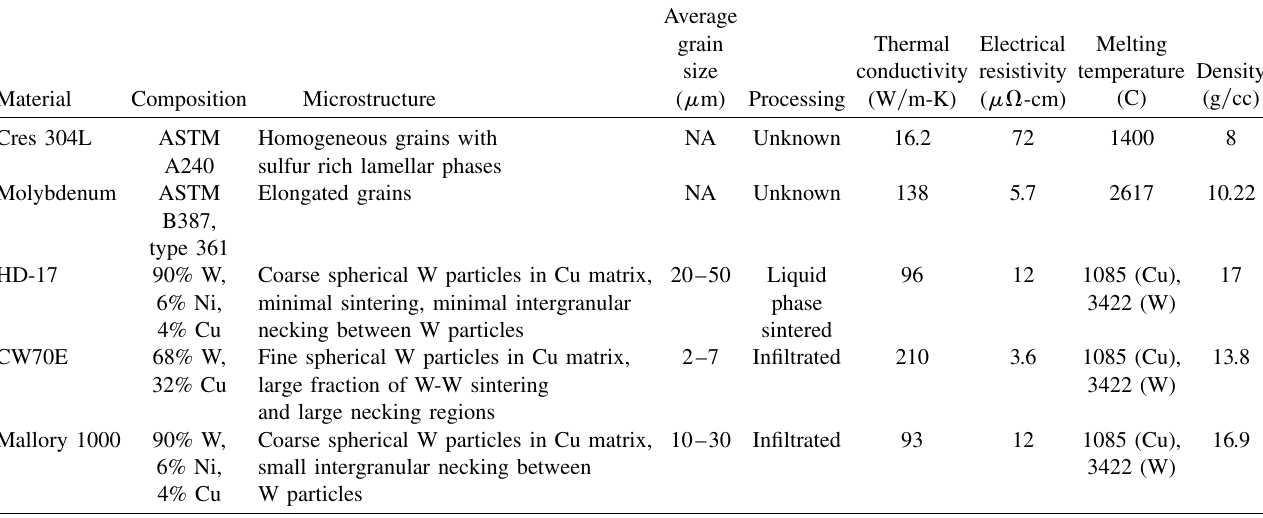
TABLE II. Summary of electrode materials tested and their